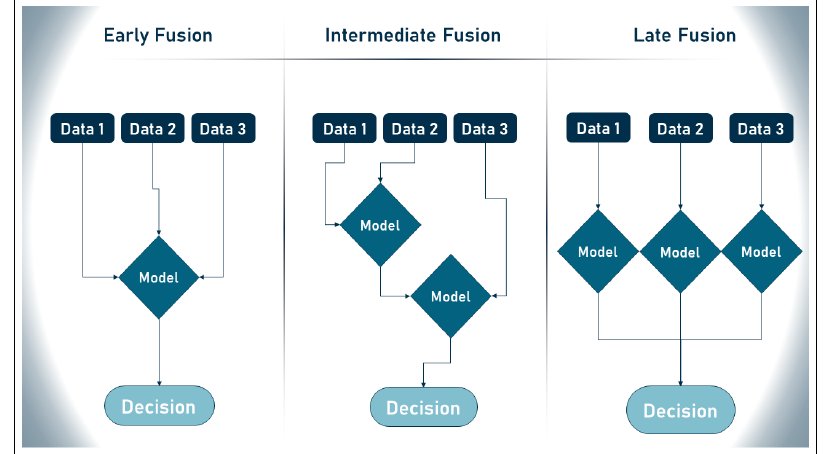
Figure 9. Data fusion different